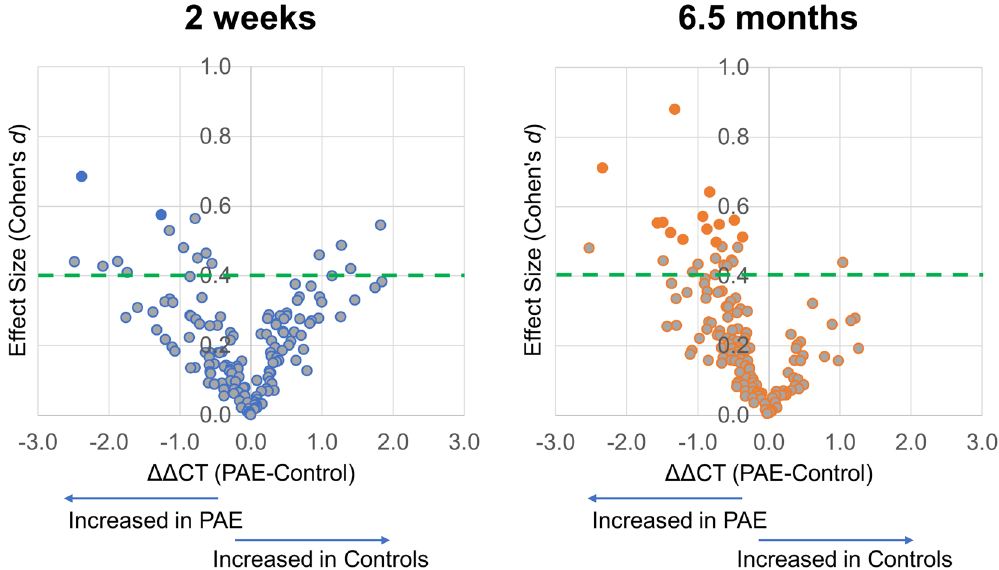
Figure 2. PAE-altered ex miRNAs in infant plasma. Volcano plots of relative expression of ex miRNAs (ΔΔCT, ΔCT PAE —ΔCT control ) and effect size (Cohen’s d ) at T 2wk (left) andT 6.5mo (right). Dashed green line denotes a clinically relevant, moderate effect size of 0.40. Orange and blue filled points denote ex miRNAs with significant effect sizes (95% confidence interval does not contain zero).